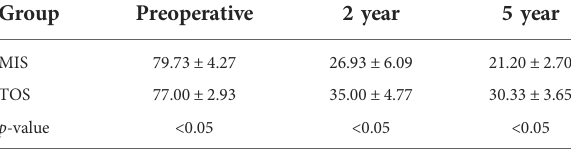
TABLE 5 ODI assessment of the two